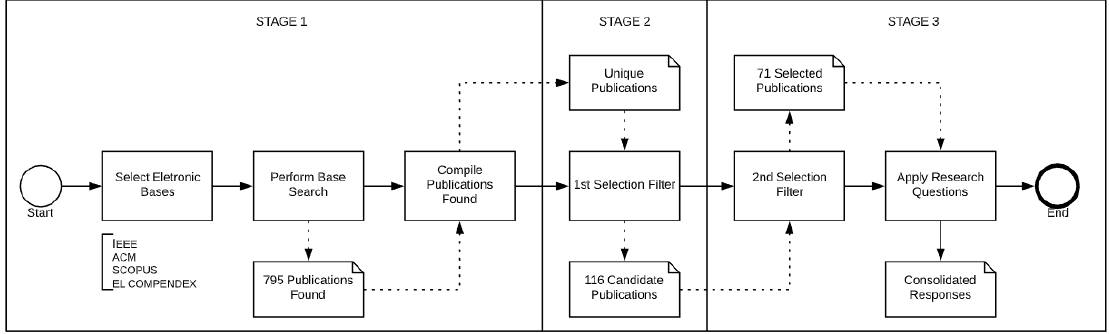
Figure 2. Stages of the search process and number of selected studies.